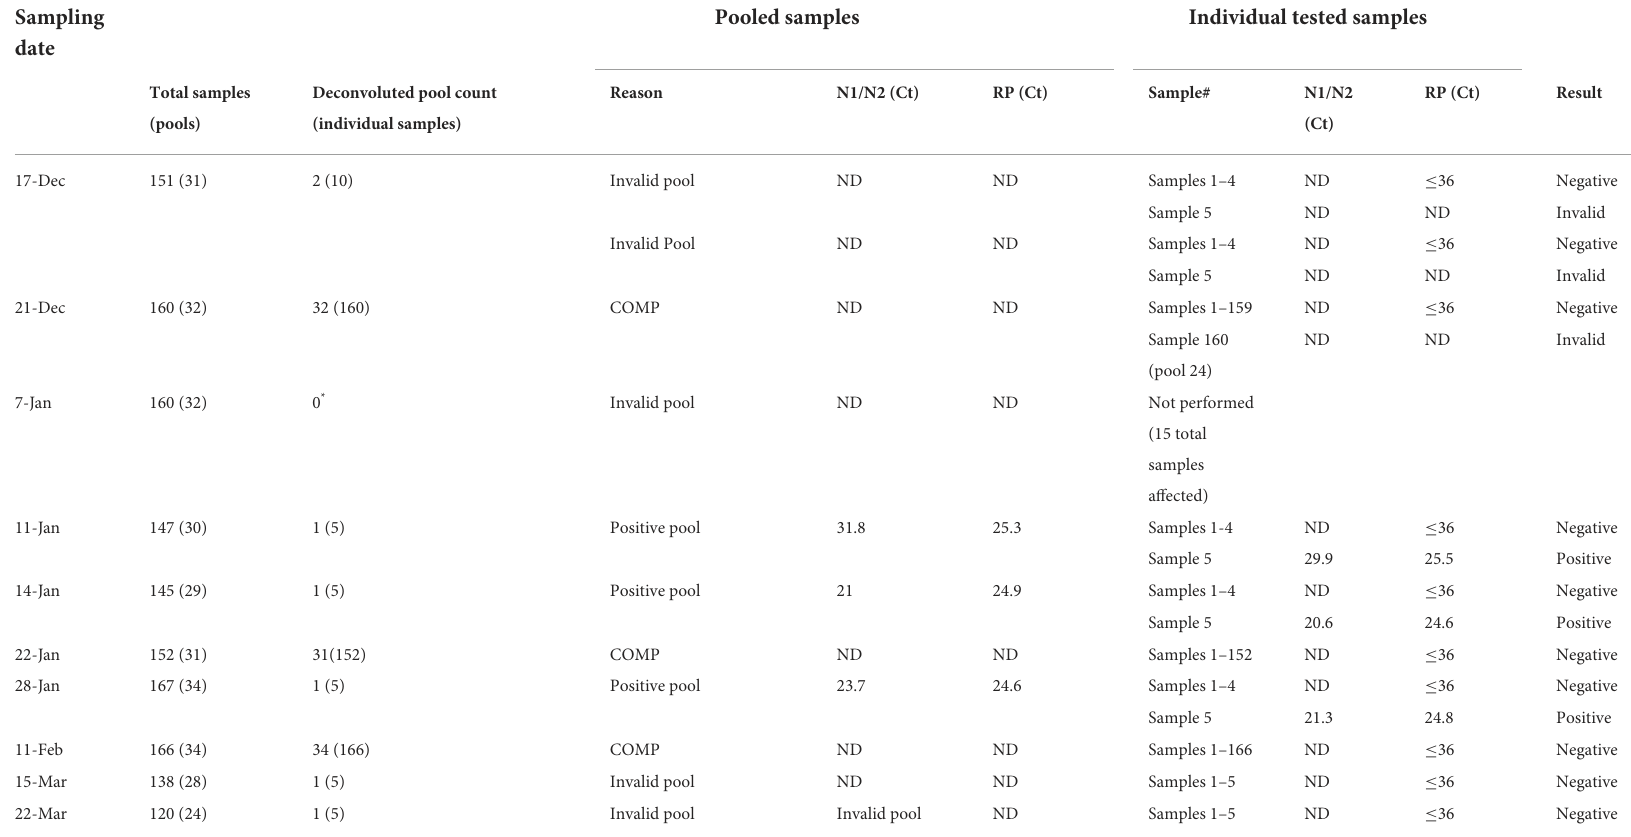
TABLE 4 Description of deconvoluted pools with Ct values for positive pools and individual